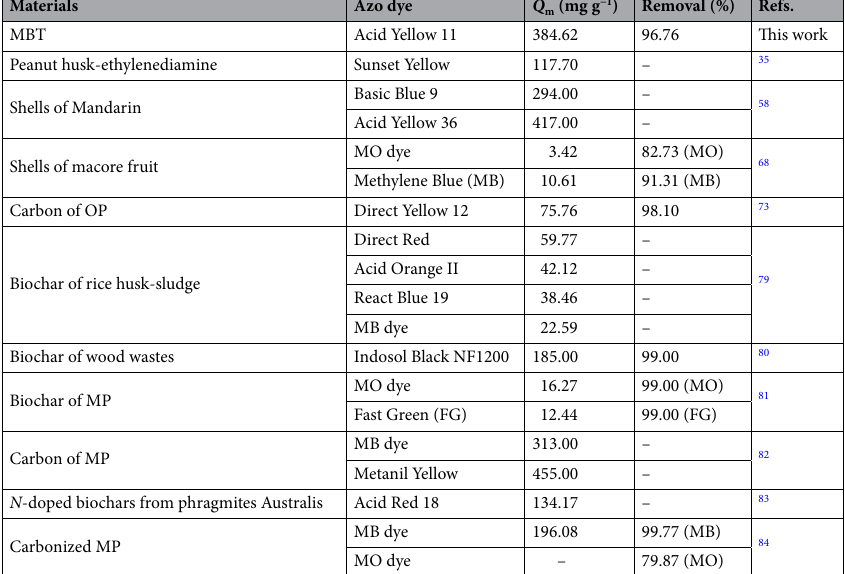
Table 5. Reported the Q m of different azo dyes by various